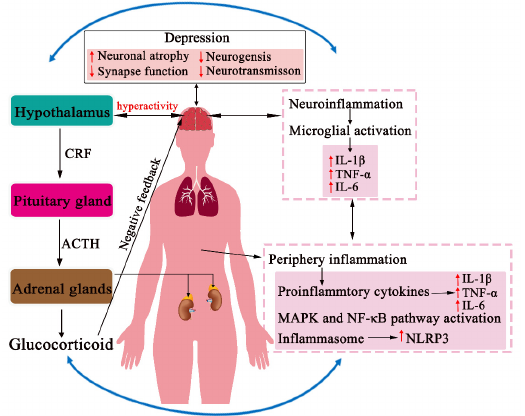
Figure 1. The neuroendocrine-immune network in the pathogenesis of depression. In response to stress, the peripheral or neuroimmune system activates the release of HPA axis hormones, whereas the stress-induced hyperactivation of the HPA axis also stimulates a proinflammatory or neuroinflammatory response. Intersystem crosstalk occurs at many levels through neural, immu- nological, and humoral interactions and subsequently results in the dysfunction of the central nervous system (CNS) in the pathogenesis of depression. 2. Inflammation in the Pathogenesis of Depression Smith first proposed that inflammation may play a crucial role in the pathogenesis of depression in 1991 [18]. Since then, the immune system has been extensively studied to explore the mechanism by which the dysfunction of immune system is associated with symptoms of depression. Accumulating evidence has demonstrated that the dysregula- tion of the peripheral or neuroimmune system contributes to the pathogenesis of depres- sion [19] (Figure 1). Clinical studies have indicated that patients suffering from depression showed significantly higher levels of proinflammatory cytokines, including interleukin- 1 β (IL-1 β ), interleukin-6 (IL-6), tumor necrosis factor alpha (TNF- α ), C-reactive protein (CRP), and inflammasome, than healthy people [6,20–24]. These studies have also shown that patients with chronic peripheral inflammatory diseases have a higher incidence of depression [25]. In addition, over 50% of patients suffering from viral infections showed a depressive symptomatology after treatment with cytokine interferon-alpha (INF- α ) [26]. The reciprocal effects were also observed in rodent models. For instance, several studies have reported that chronic unpredictable mild stress (CUMS) treatment elevated the pro- inflammatory or neuroinflammatory response of the immune system in the blood and brain [27–29], whereas the administration of endotoxins, such as lipopolysaccharide (LPS), caused depressive-like behaviors by activating the indoleamine 2,3-dioxygenase (IDO) pathway [30] or proinflammatory cytokines [31]. These studies indicate that bidirectional communication exists between proinflammation or neuroinflammation and the CNS. It is worth noting that the dysregulation of the peripheral immune system plays an important role in the pathogenesis of depression. Peripheral cytokines can be actively transported into the CNS through an increase in blood brain barrier (BBB) permeability [19,32,33] and, subsequently, a reduction of serotonin neurotransmission and activation of the HPA axis [34]. Interestingly, low levels of proinflammatory cytokines regulate